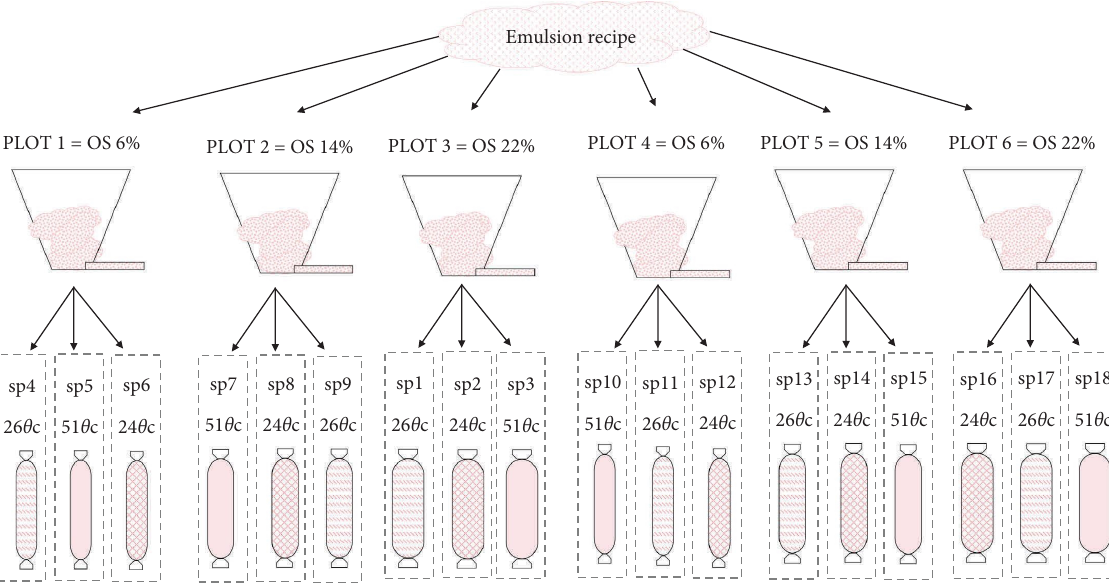
Figure 1: Schematic diagram of the experimental plan for the split-plot structure used to verify the efects of over-stufng (OS) and contact angle ( θ c) of plastic casing on purge losses. (sp � subplot; n � 5 samples per each sp). Same diagram was used to prepare stufed samples of meat emulsion recipes R 1 and R 2 . Table 3: Relation between over-stufng percentage and diameter of stufed